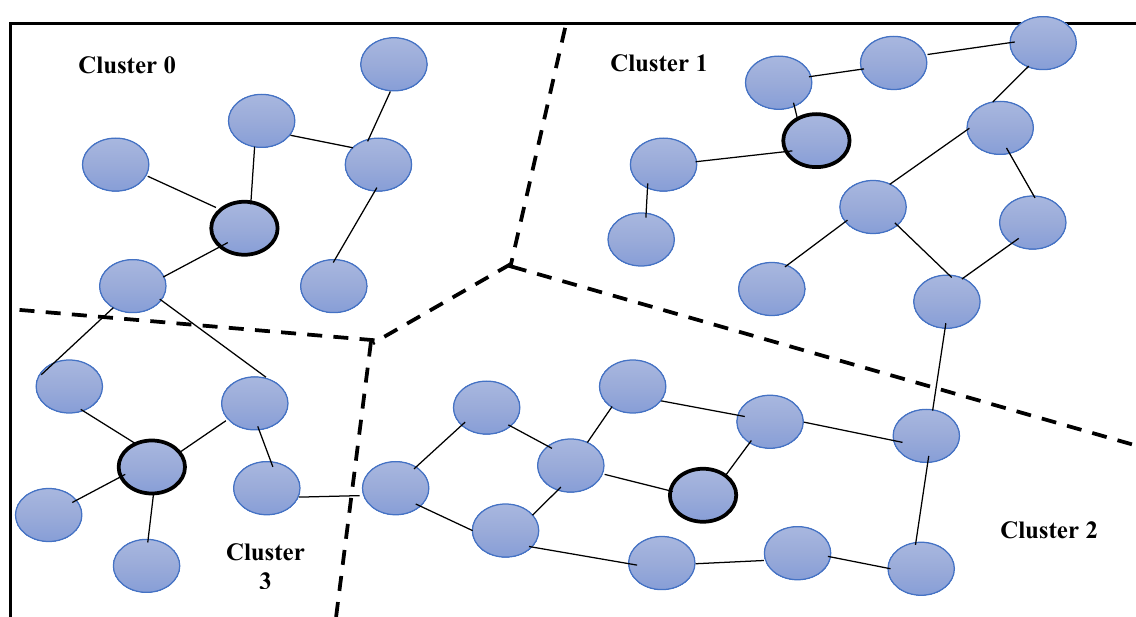
Figure 1. Structure of WSN [4]